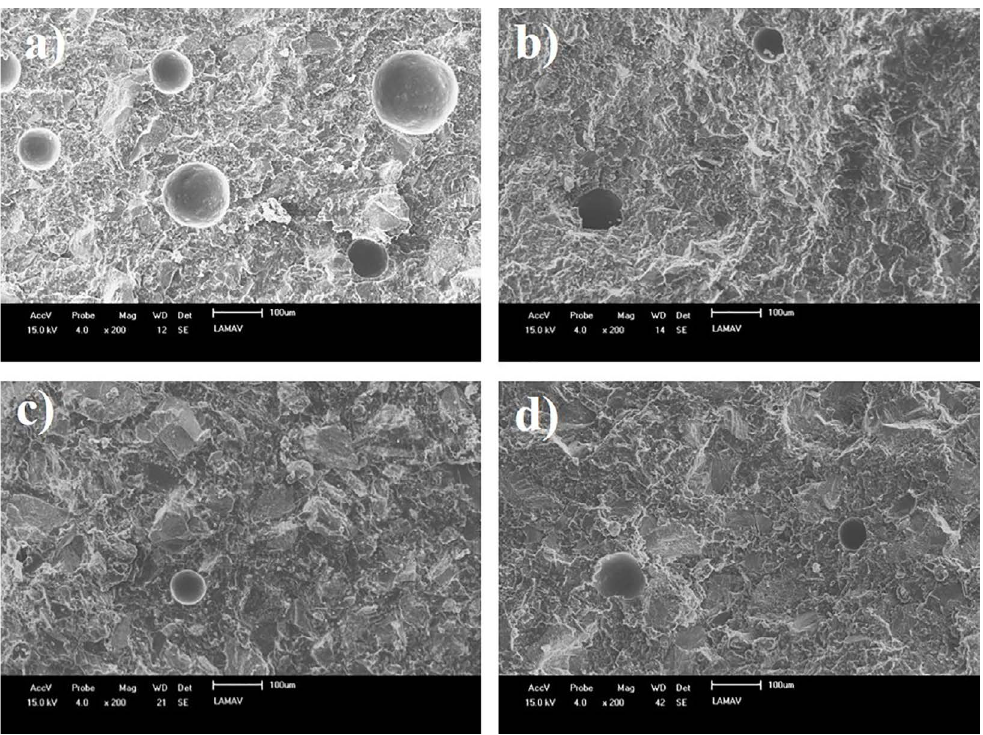
Figure 5. SEM micrographs of the artificial rocks produced with chicken eggshell waste (< 100 mesh): a) 50/50; b) 55/45; c) 60/40; and d)